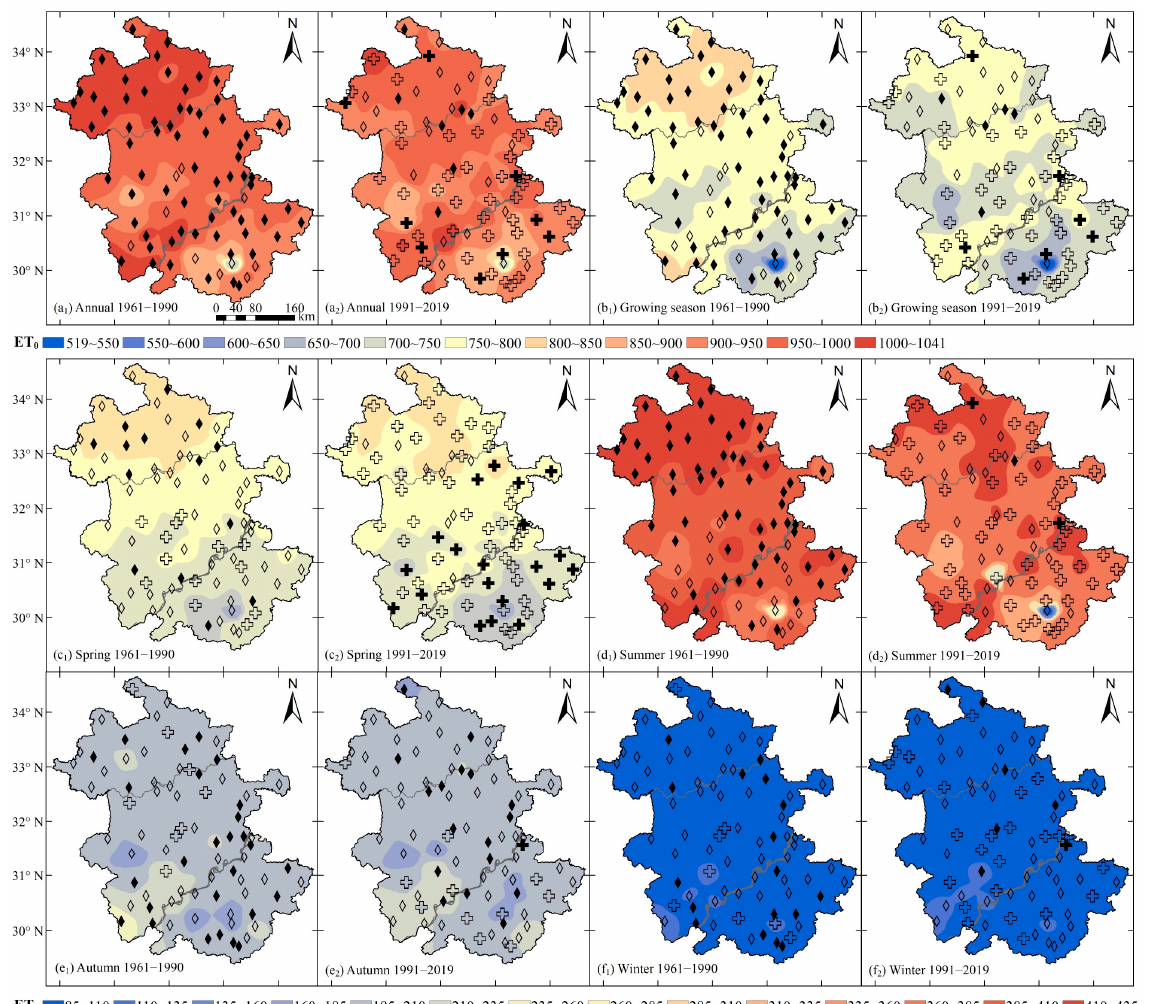
Figure 3. Spatial trends of ET 0 during 1961–1990 and 1991–2019 in Anhui province. Note: Solid (hollow) rhombus and plus sign indicate significant (insignificant) downward and upward trends, respectively.